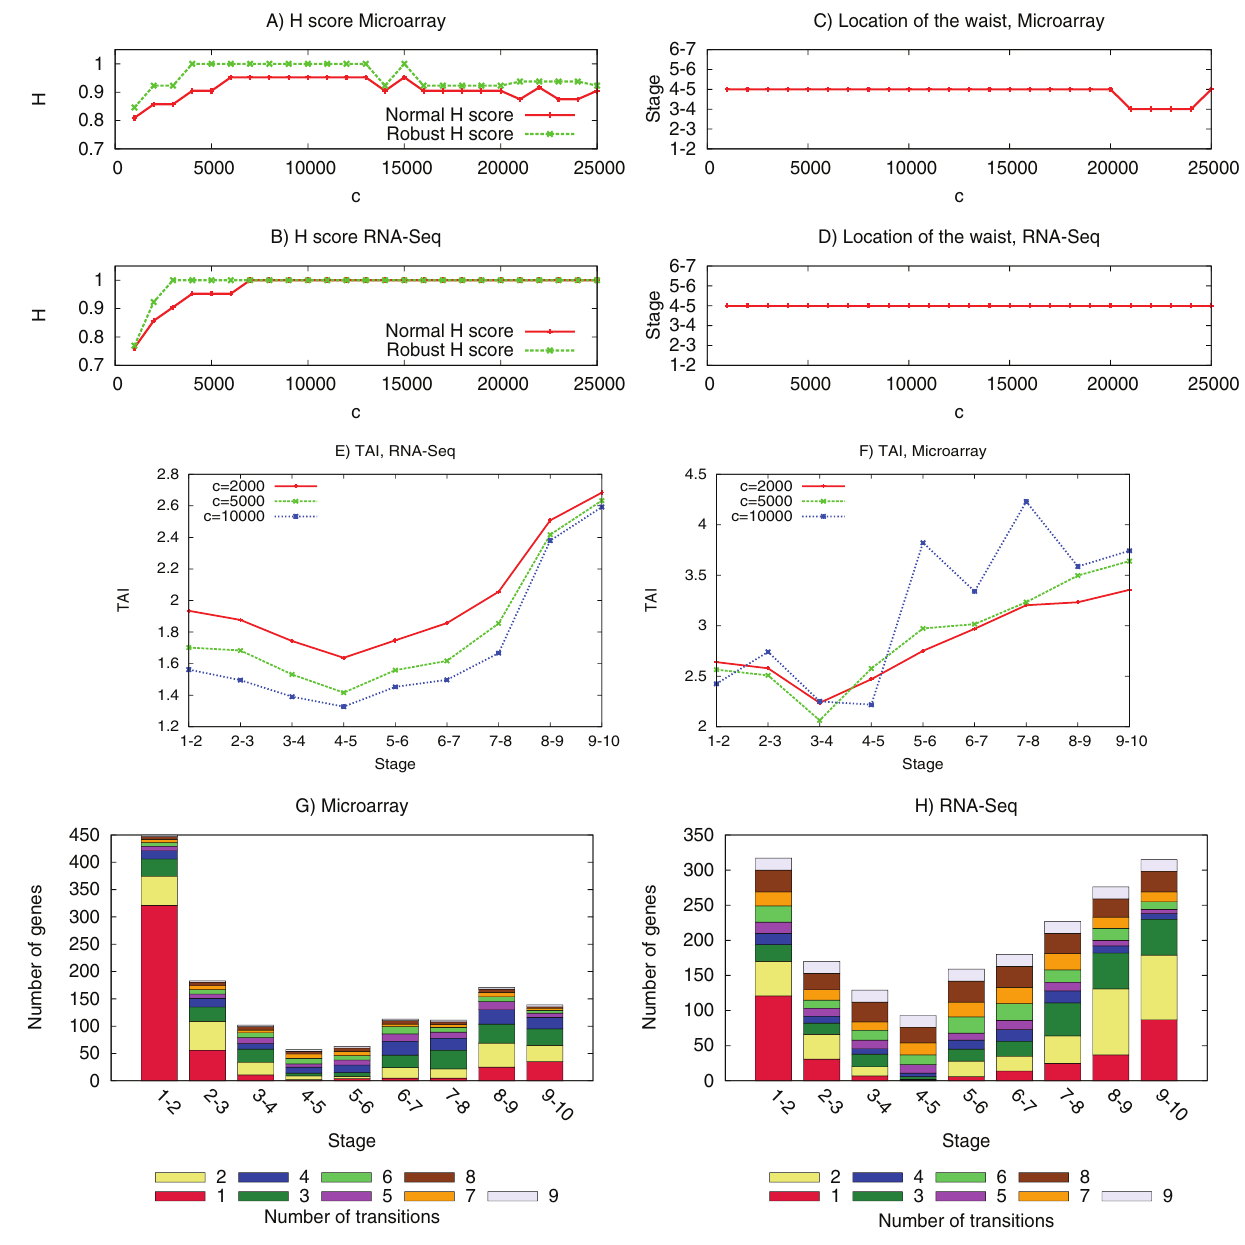
Figure S2. Drosophila results using absolute expression levels. Graphs ( a ) and ( b ) show the hourglass score (normal and robust) as a function of the transition threshold c for the two datasets. Graphs ( c ) and ( d ) show the location of the hourglass waist (stage-pair) as a function of the transition threshold c for the two datasets. Graphs ( e ) and ( f ) show the Transcriptome Age Index of transitioning genes for three different values of c (chosen so that the number of genes with known age index assigned to each stage is at least 10) for the two datasets. Graph shows the transitioning genes for the Microarray dataset with c = 5000. The transitioning genes constitute 21% of all genes in that dataset. 62% of those genes transition in a single stage-pair. Of the remaining, 58% transition only in consecutive stage-pairs. Similarly, graph ( h ) shows the transitioning genes for the RNA-Seq dataset with c = 10000. The transitioning genes constitute 5% of all genes in that dataset. 45% of those genes transition in a single stage-pair. Of the remaining, 53% transition only in consecutive stage-pairs. [Dataset